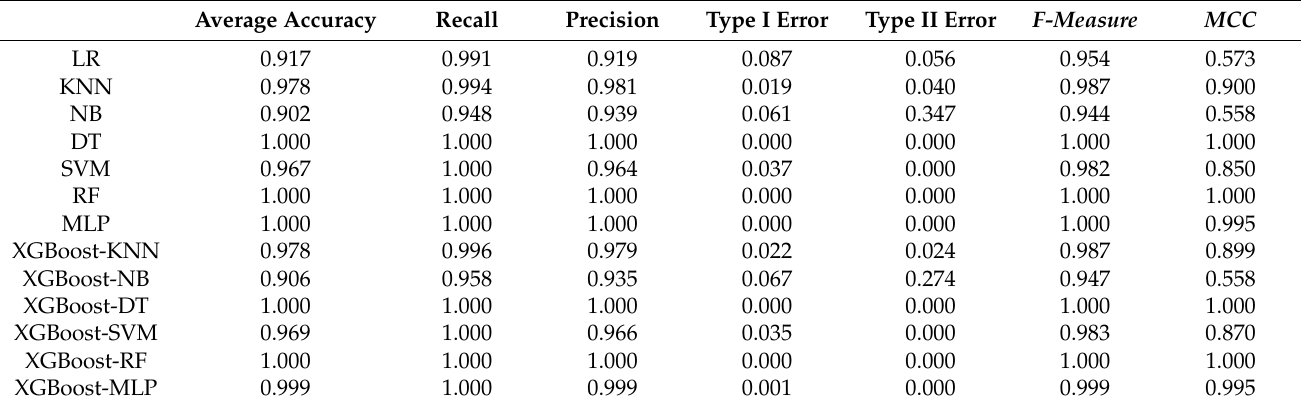
Table 5. Performance of XGBoost-MLP and other machine learning methods. (In